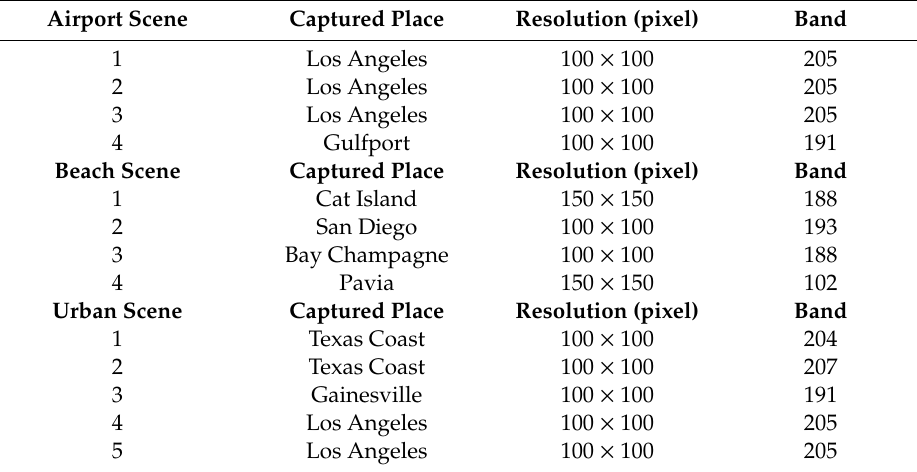
Table 1. Features of the Airport–Beach–Urban (ABU)